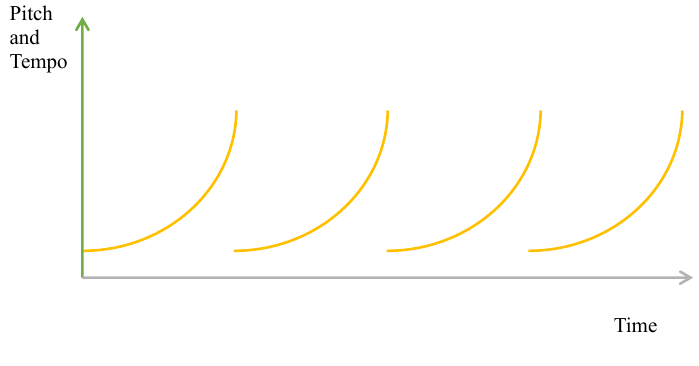
Figure 7. Visual Representation of “The Drop”